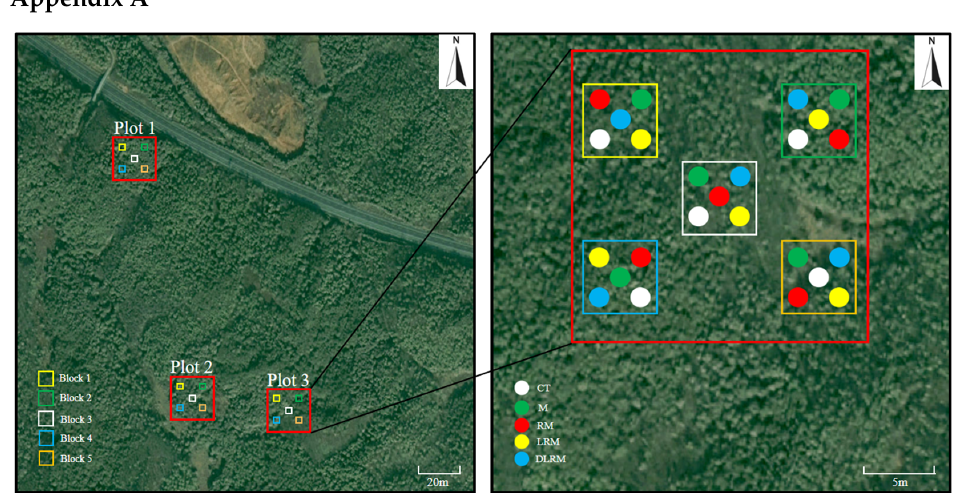
Figure A1. Locations of the plots and treatments of Schima superba forests. CT, control treatment; M, mycorrhiza; RM, root + mycorrhiza; LRM, litter + root + mycorrhiza; DLRM, double litter + root + mycorrhiza. Table A1. Relative abundance of major soil bacteria and fungi at class level in different treatments (%).